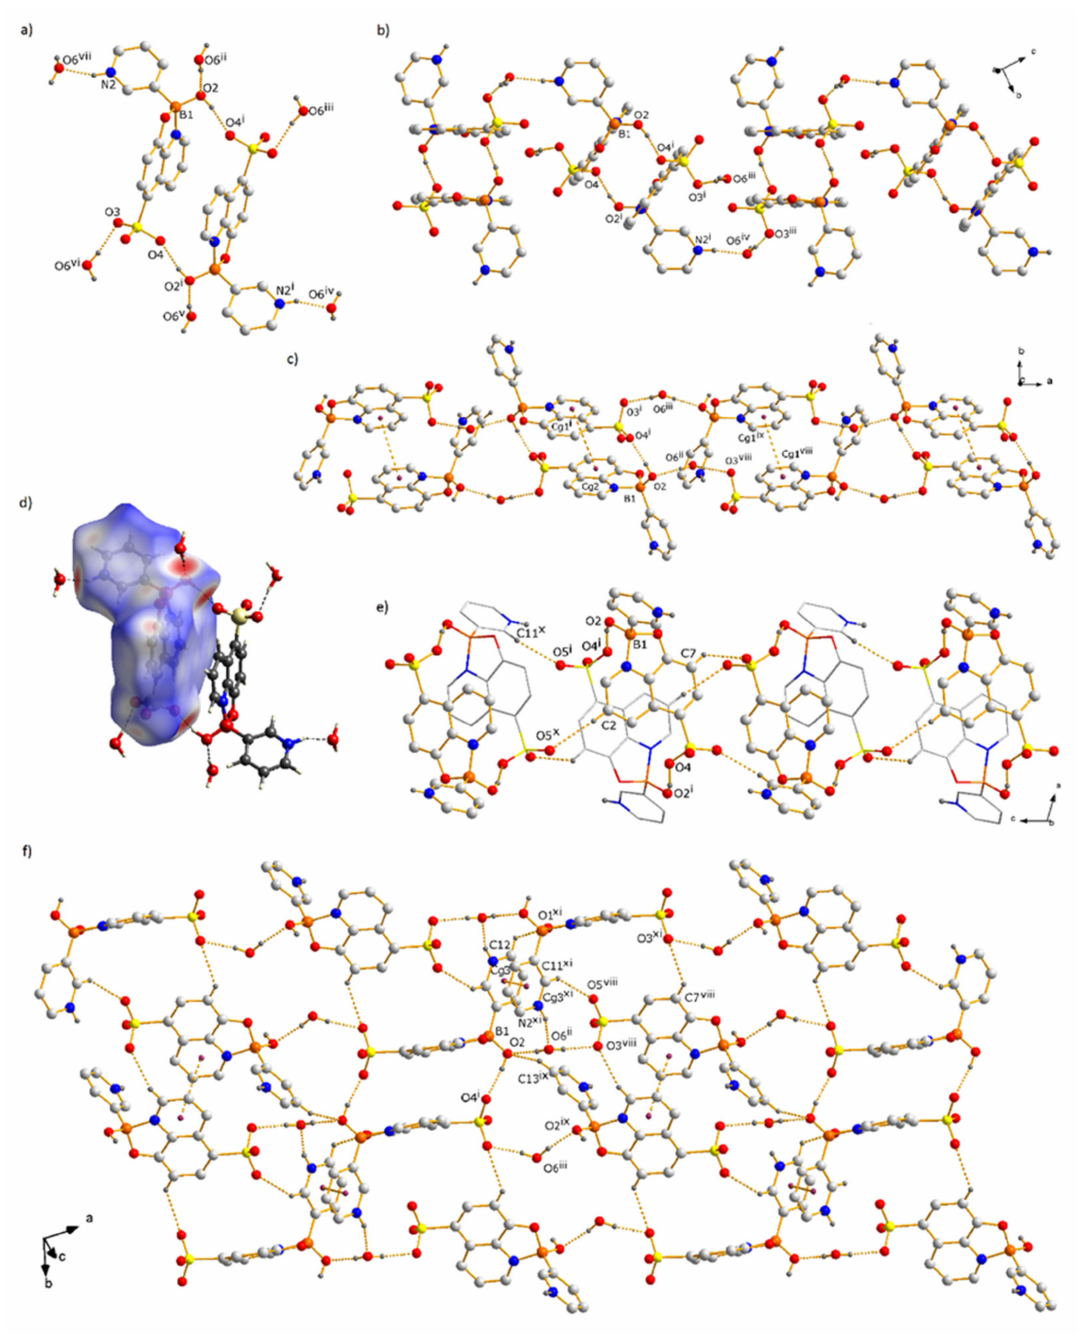
Figure 3. Fragments of the crystal structure and Hirshfeld surface map of compound 1 , showing hydrogen-bonding motifs and π – π interactions ( a – f ). Symmetry operators: (i) 1-x,1-y,1-z; (ii) 2-x,1-y,1- z; (iii) x,1.5-y,0.5+z; (iv) 1-x,2-y,1-z; (v) − 1+x,y,z; (vi) 1-x, − 0.5+y,0.5-z; (vii) x, − 1+y,z; (viii) 1+x,0.5- y,0.5+z; (ix) 2-x,0.5+y,1.5-z; (x) x,0.5-y,0.5+z; (xi)